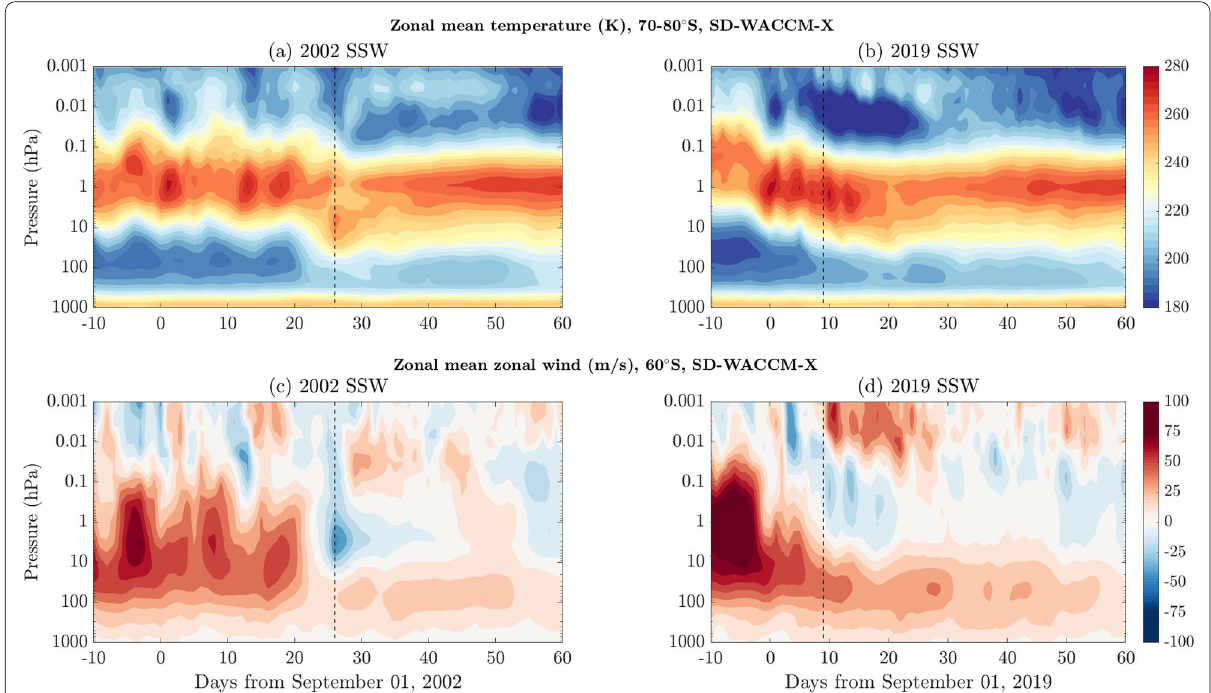
Fig. 2 The top panels present the daily zonal-mean temperature (K) averaged between 70 ◦ S and 80 ◦ S as a function of pressure levels from SD-WACCM-X simulations for (a) 2002 and (b) 2019 SH SSWs. The bottom panels present the SD-WACCM-X simulated daily zonal-mean zonal winds at 60 ◦ S as a function of pressure levels for both SSWs in c , d . The black dashed lines mark the day of polar vortex weakening (PVW) for the corresponding